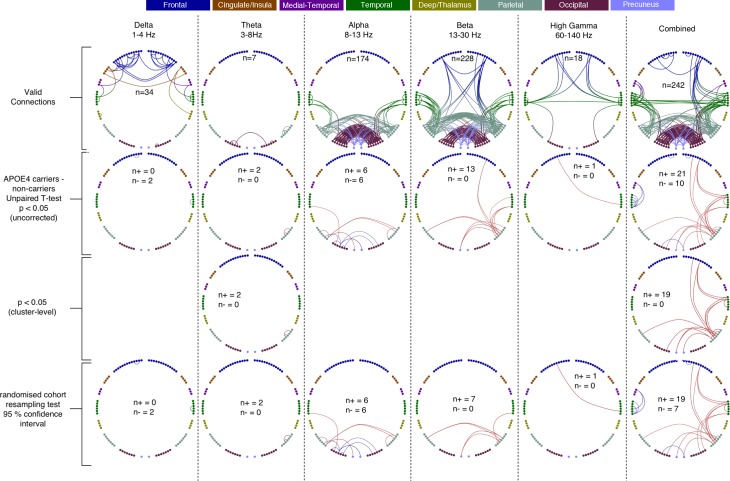
Each column shows oscillatory amplitude correlations comparing APOE-ɛ4 carriers and non-carriers for each of the five frequency ranges where valid edges were found, and combined across frequency.The top row shows where there are ‘valid’ edge connections in either of the two groups. Colours, with a key at the top of the figure, indicate regions of brain areas that the connections originate from. The numbers on the plots show the number of valid edges found. Note that Low Gamma is not shown as no ‘valid’ edges were found. The second row shows the unpaired t-statistic for APOE-ɛ4 carriers compared to non-carriers. Increases are displayed in red and decreases in blue and only those connections significant at p<0.05 (uncorrected) are shown. The numbers on each plot (n+/n-) show the number of significant increases and decreases found in each map. Note that, across all tests, only one edge connection, in the Theta band, was found to be significantly different when corrected for multiple comparisons (p<0.036, right parietal). Using the cluster-level network-based size statistic, shown in the third row, significantly large clusters were found for the theta and Combined maps. The bottom, fourth row, shows the results of the cohort random sampling analysis. Edges are only shown if they are within the 95% confidence limit for APOE-ɛ4 -related increases (red) or decreases (blue). Note that, in general, the predominant effect is for edges to show increases in connectivity in APOE-ɛ4 carriers, compared to non-carriers and that this is most clearly shown in the Combined map (right-hand column), in which the most valid connections are identified and the most significant, and consistent, differences are seen. In all connection plots, line opacity indicates relative connection strength within the plot (most opaque = strongest). Data and scripts needed to generate this figure can be found at http://dx.doi.org/10.17605/OSF.IO/E4CJX.